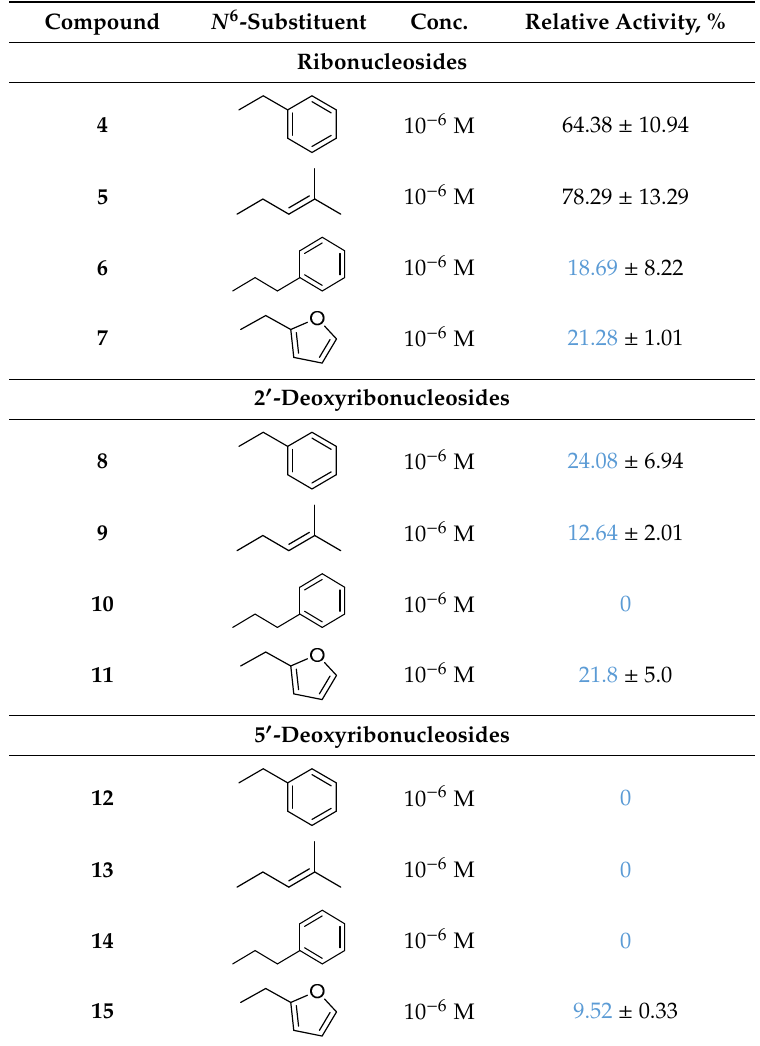
Table 2. Cytokinin activity (in %) of nucleoside derivatives in bioassay based on Amaranthus caudatus Table 1. Cytokinin activity (in %) of nucleoside derivatives (at two concentrations) in bioassay based Table 1. Cytokinin activity (in %) of nucleoside derivatives (at two concentrations) in bioassay based Table 1. Cytokinin activity (in %) of nucleoside derivatives (at two concentrations) in bioassay based Table 1. Cytokinin activity (in %) of nucleoside derivatives (at two concentrations) in bioassay based seedlings. BA activity was taken as 100% *. on Arabidopsis thaliana double mutants. BA activity was taken as 100% 1 . on Arabidopsis thaliana double mutants. BA activity was taken as 100% 1 . on Arabidopsis thaliana double mutants. BA activity was taken as 100% 1 . on Arabidopsis thaliana double mutants. BA activity was taken as 100% 1 . Compound N 6 -Substituent Conc. Relative Activity, % Ribonucleosides 4